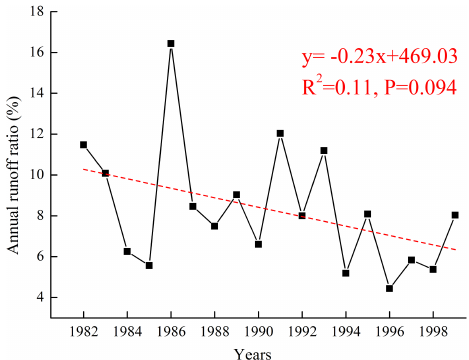
Figure 8. Trend in the annual runoff ratio from 1982 to